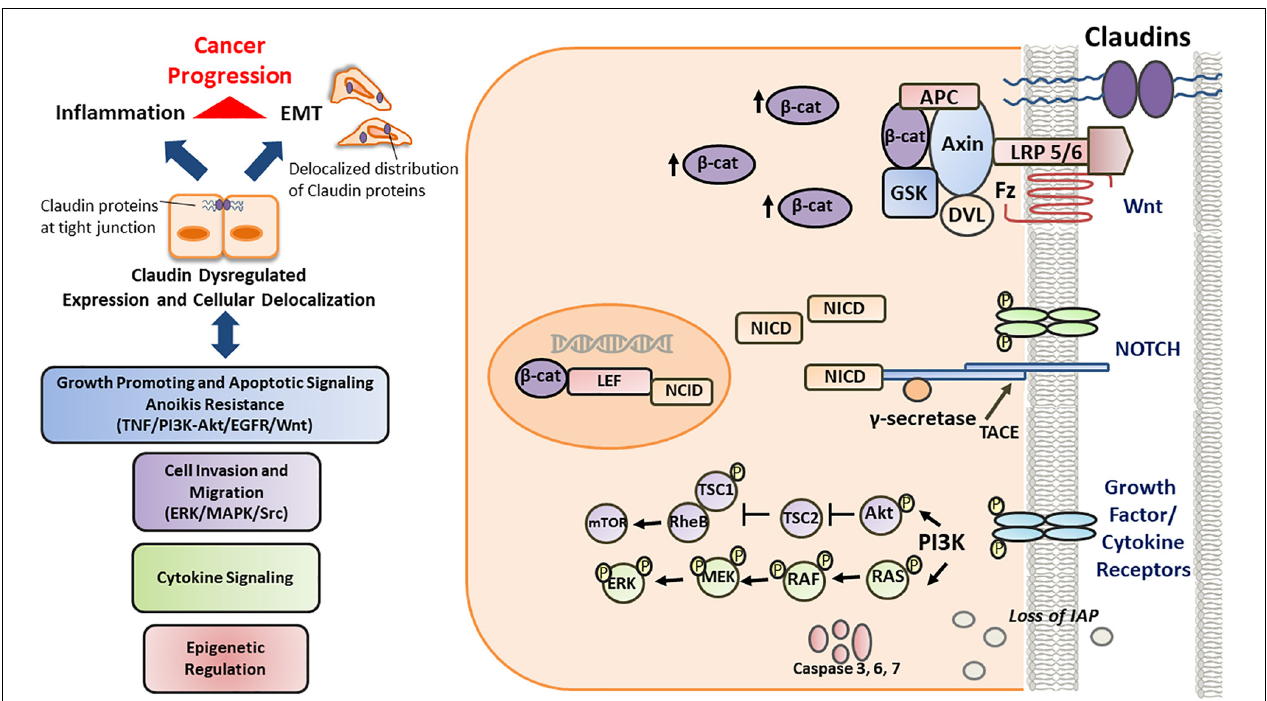
FIGURE 3 | Schematic/proposed signaling model of role and regulation of claudins in a cell during invasive or metastatic stage. Deregulated claudin expression and delocalization occurs as a consequence of epigenetic factors, growth factors and cytokines, inducing loss of “gate and barrier” function and thereby promoting inflammation, EMT and disease progression. Once the cell is destined to be a tumor cell, it further becomes more aggressive. During this stage, the well-regulated junctional molecules between cells become more and more permissible to various factors responsible for the up regulation of the survival, rapid growth and proliferative signaling pathways. Also, the inhibitor for apoptosis (IAP) proteins, which are critical for inhibiting cancer cell death and promoting their survival, are also upregulated. Further, along with the PI3-K/Akt and RAS-RAF-ERK pathways, NOTCH pathway is also upregulated which further enhances the growth potential of the cancer cell. Further, tight junctional protein, such as claudin-1 is associated with beta-catenin and help in the enhanced translocation of beta catenin into the nucleus. At this stage both the NOTCH and the Wnt pathway act in co-ordination to enhance the metastatic potential of the cancer